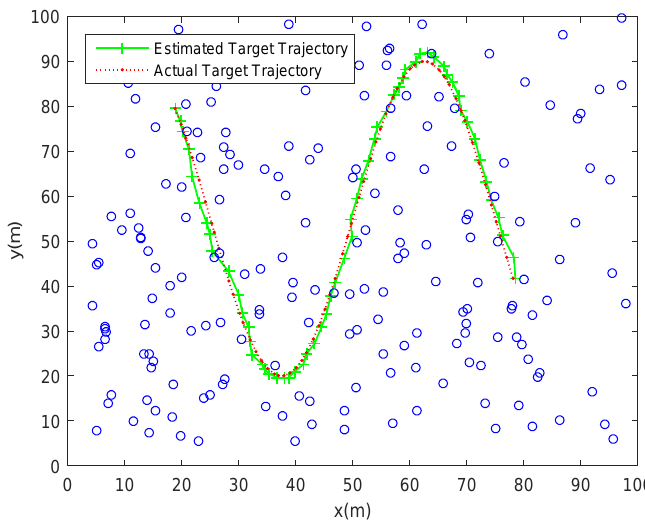
Figure 8. One of tracking trajectories using our proposed tracking scheme in a randomly distributed sensor network.